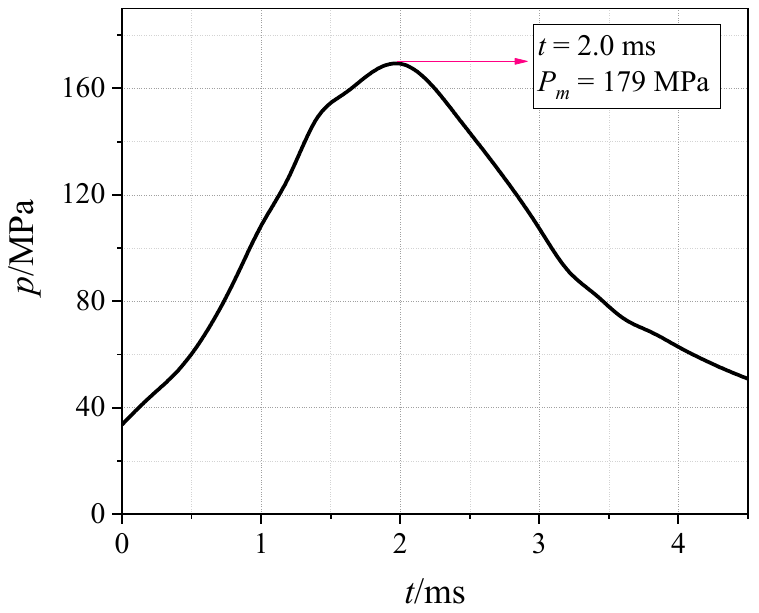
Figure 4. Pressure curve of the combustion chamber in the experiment. In the experiment, eight IVMDs are used to obtain the flight velocity of the fragment in the air. The distance between the first IVMD and muzzle of the launching system is 4.54 m. The distance between the first and fourth IVMDs is 6.242 m. The distance between the second and third IVMDs is 5.8 m. The distance between the fourth and fifth IVMDs is 6.8 m. The distance between the fifth and eighth IVMDs is 5.199 m. The distance between the sixth and seventh IVMDs is 4.755 m. The experimental results show that the fragment flies through these eight IVMDs at 2.616 ms, 2.737 ms, 5.987 ms, 6.114 ms, 10.172 ms, 10.309 ms, 13.323 ms and 13.467 ms. The distance between group IVMDs and corresponding